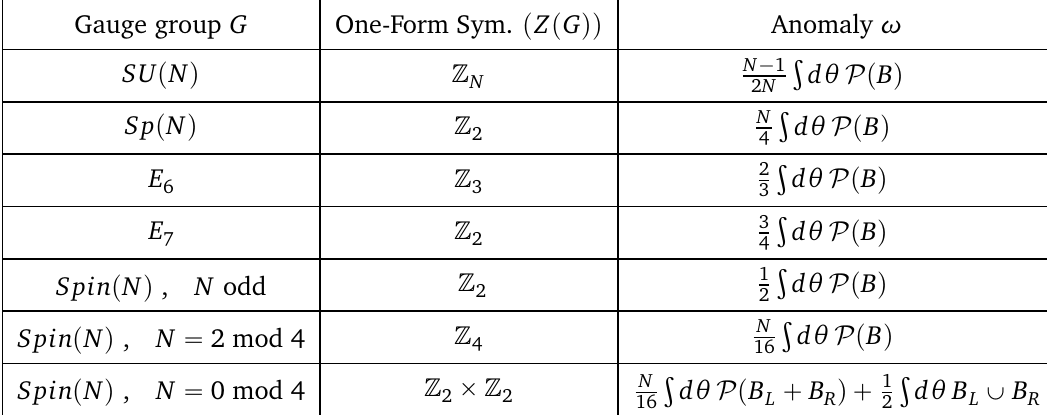
N 2 (cid:90) 3 (cid:90) 2